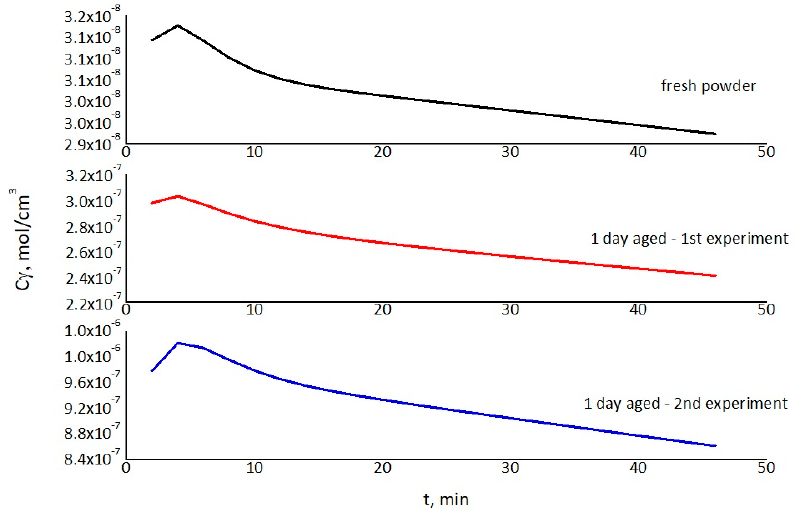
Figure 10. The aging e ff ect on the non-adsorbed hydrogen concentration on the catalyst surface of fresh catalyst, 1 day aged catalyst (first experiment), and 1 day aged catalyst (second experiment) concerning the system H 2 / Ni (75 mL of water in the initial